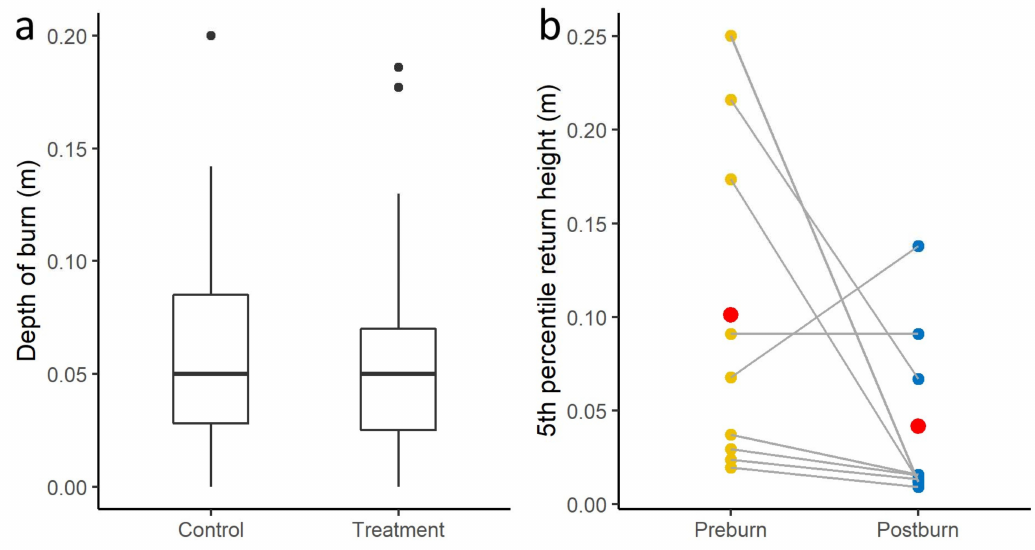
Figure 6. ( a ) Observed moss and organic soil consumption depth as measured by burn pins, and ( b ) corresponding decrease in 5th percentile LiDAR return heights. Red dots represent means of all LiDAR collection sites ( n = 9); grey lines between dots show site-wise